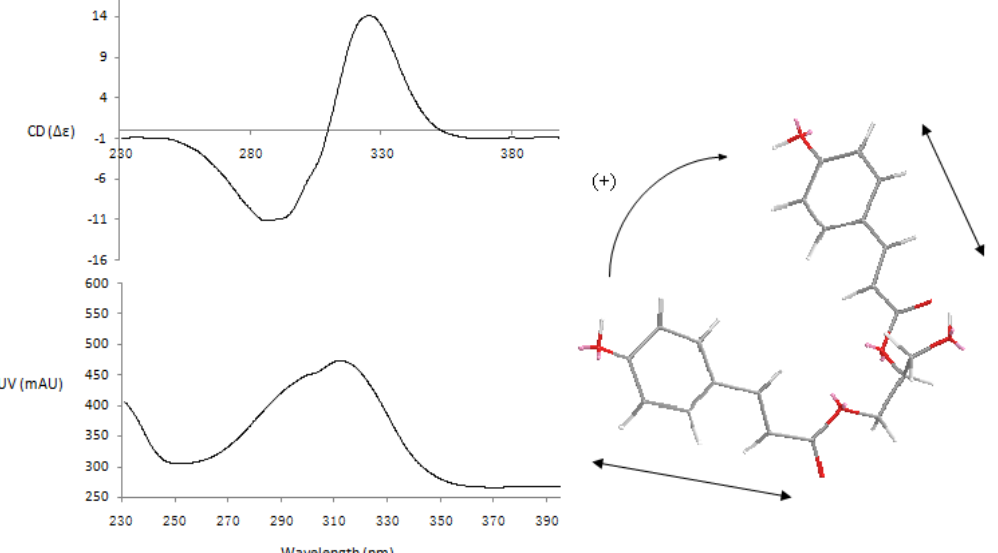
Figure 4. CD and UV spectra of compound 43